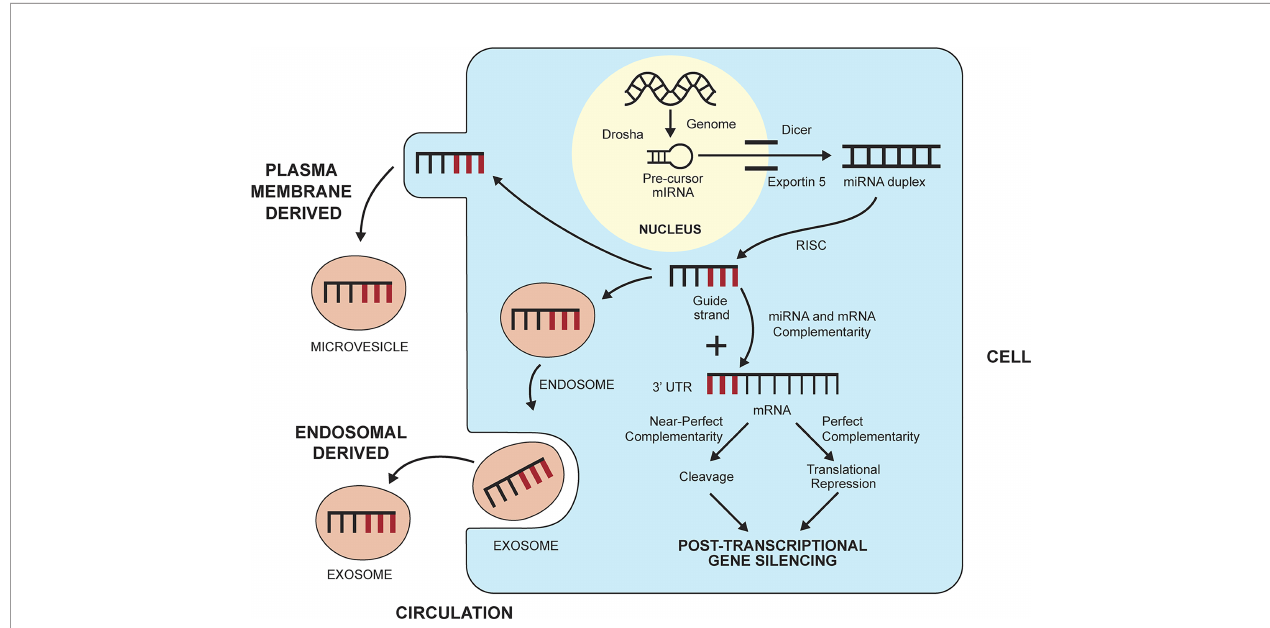
FIGURE 2 | Biogenesis and gene silencing action of micro-ribonucleic acids (miRNAs). MiRNAs are derived from the cell genome and processed within the nucleus by the ribonuclease III enzyme, Drosha, into pre-cursor miRNA. The precursor miRNA is transported to the cytoplasm by exportin 5 and processed further by the ribonuclease II enzyme, Dicer, to a miRNA duplex. The duplex is processed in a RNA-induced silencing complex (RISC), and the strand with less stable 5 ’ end is selected as the guide strand. The guide strand probes for complementary base pairs (bold lines) in the 3 ’ untranslated region (3 ’ UTR) of messenger RNA (mRNA). The degree of complementarity between the guide strand and the mRNA determines if the mRNA will undergo cleavage by endonucleases (perfect complementarity) or translational repression (near perfect complementarity). Either fate induces post-transcriptional gene silencing. MiRNAs can leave the cell and enter the circulation by forming a plasma membrane-derived microvesicle or an endosomal-derived exosome.